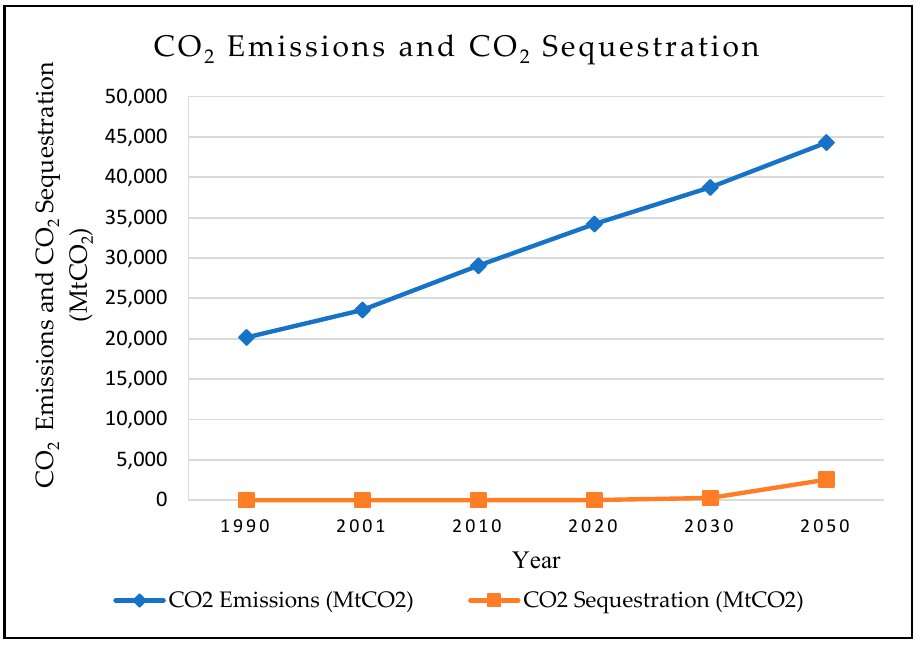
Figure 2. Global CO 2 emissions in conjunction with CO 2 sequestration from 1990 to 2050 (data source: World Energy Technology Outlook 2050 [3]).